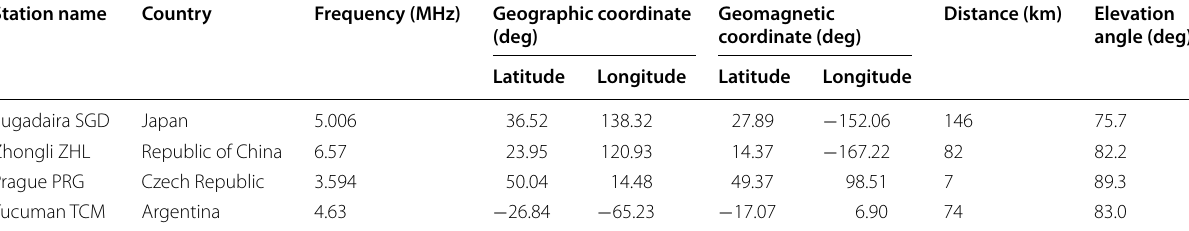
Table 1 List of the HF Doppler sounders in Japan, Argentina, Czech Republic and Republic of